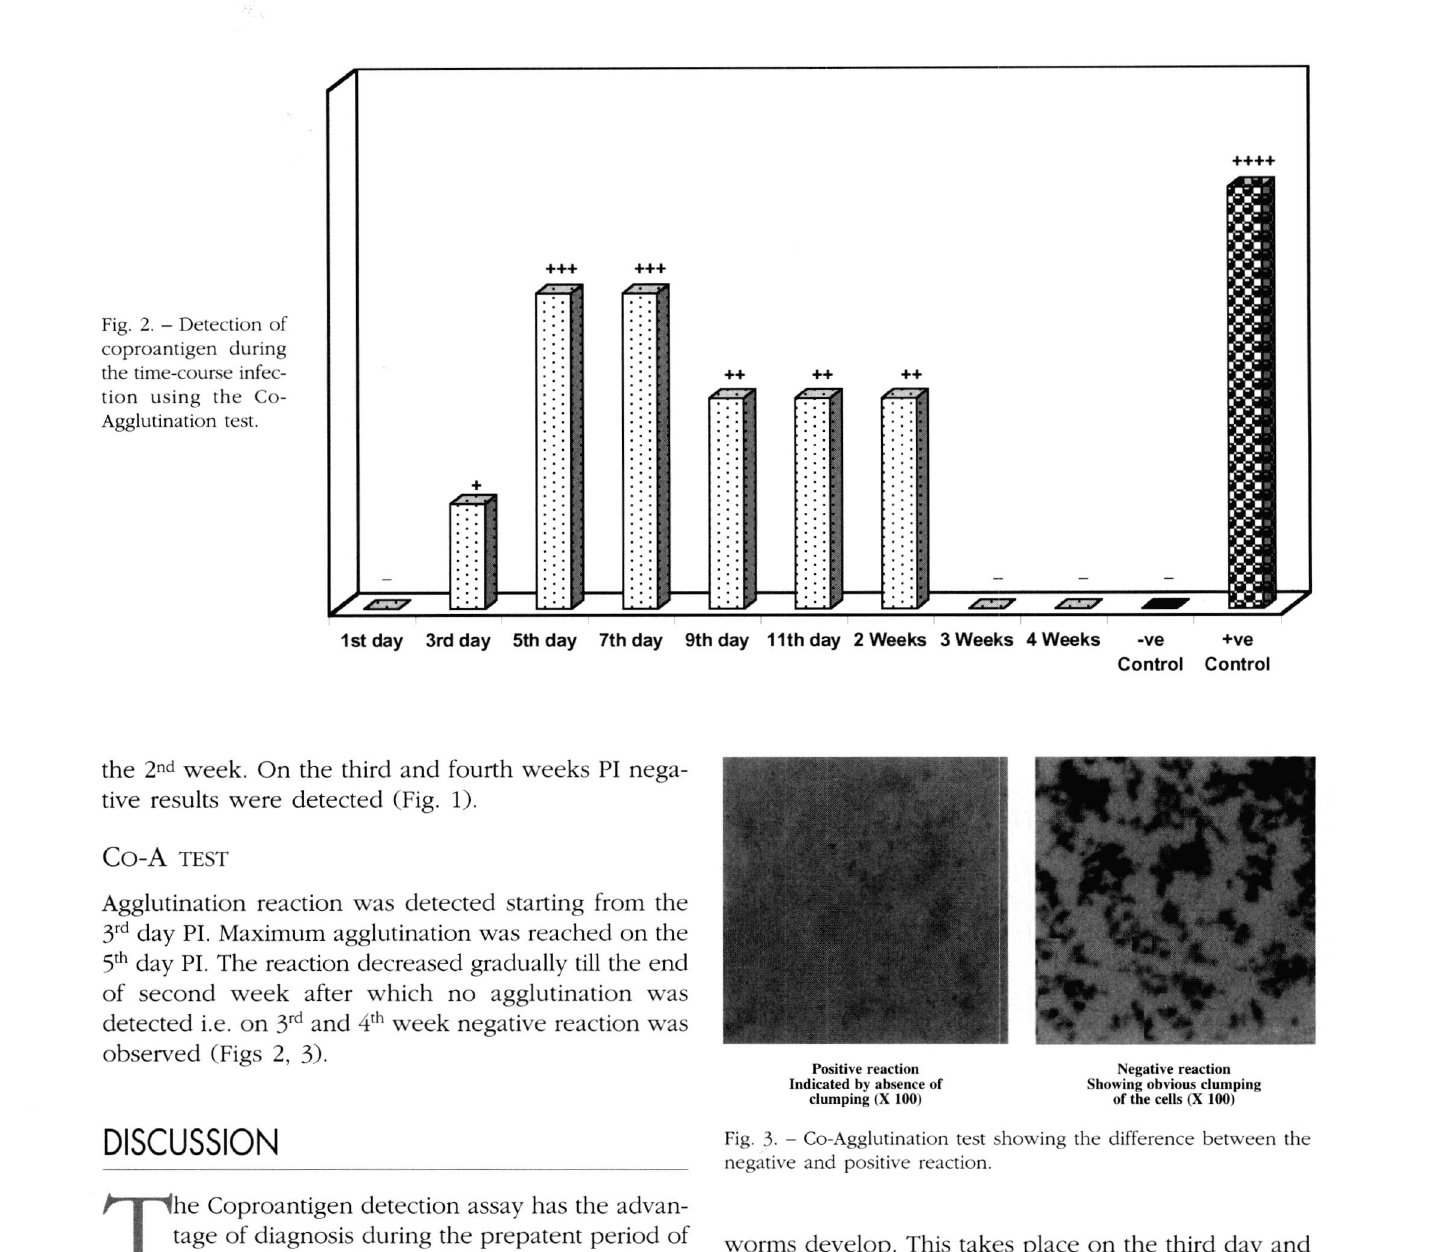
Fig. 2. - Detection of coproantigen during the time-course infec tion using the Co- Agglutination test.